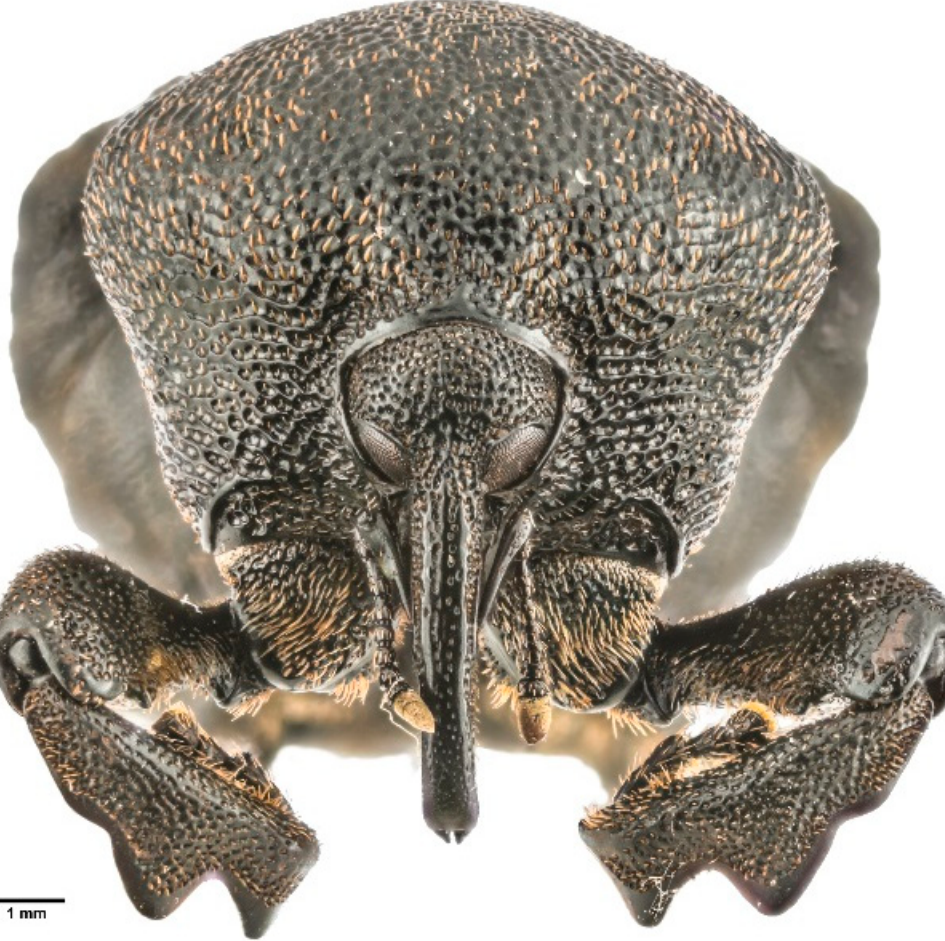
Figure 3. Sclerocardius bohemani Schoenherr: head and prothorax, anterior (holotype of Charactocnemus hintzi Hartmann). Photograph by Marc Srour (Museum für Tierkunde).